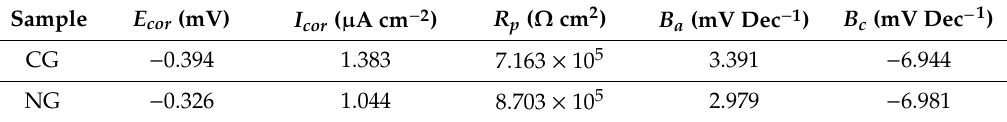
Table 3. Electrochemical parameters of the polarization